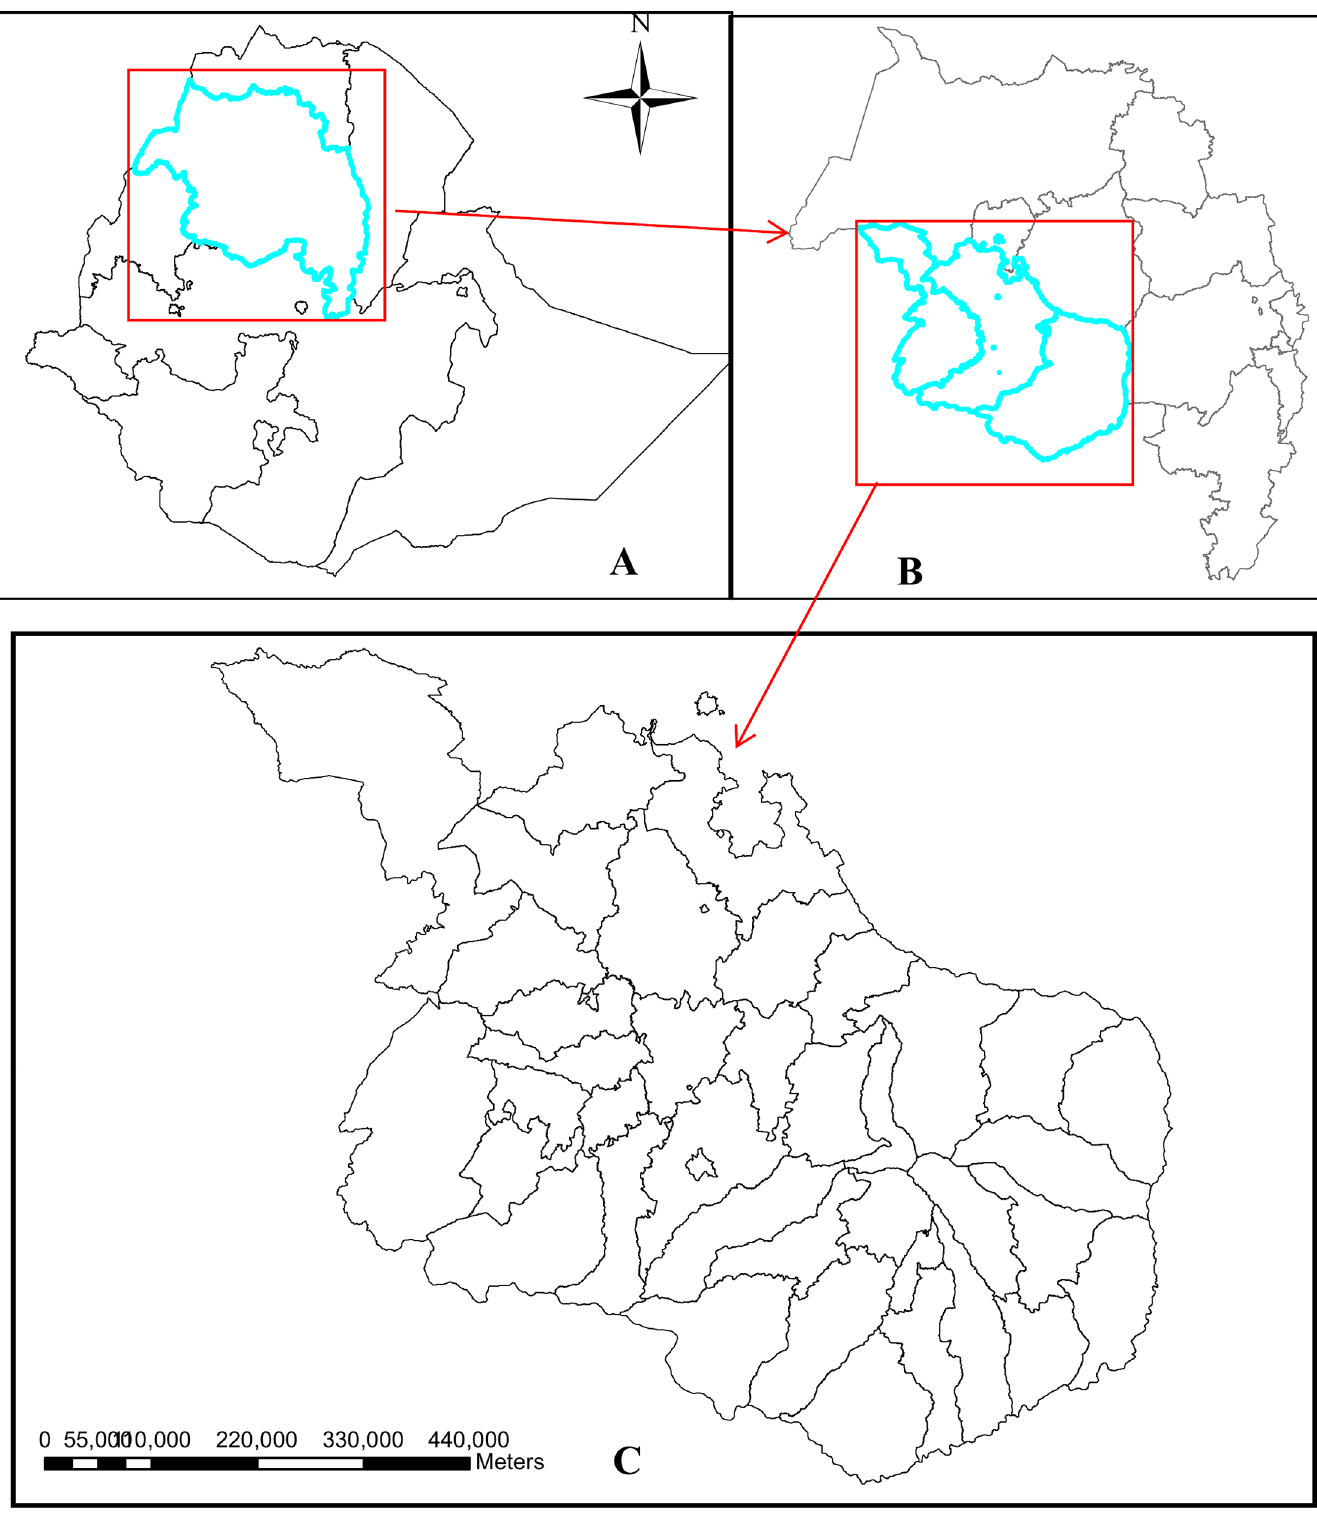
Fig 1. Location of Ethiopia (picture A), Amhara National Regional State (picture B) and the study area (Picture C).